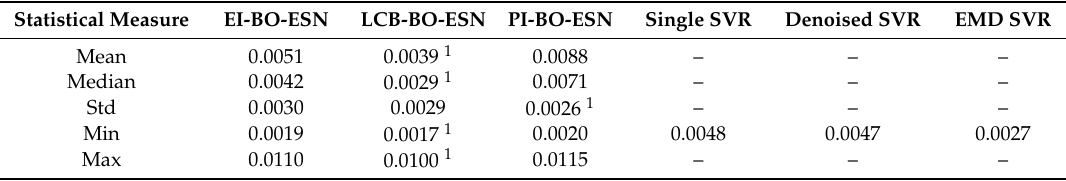
Table 3. Statistical measures over best fit mean squared error (MSE) values found over the 50 runs on the Polish dataset.